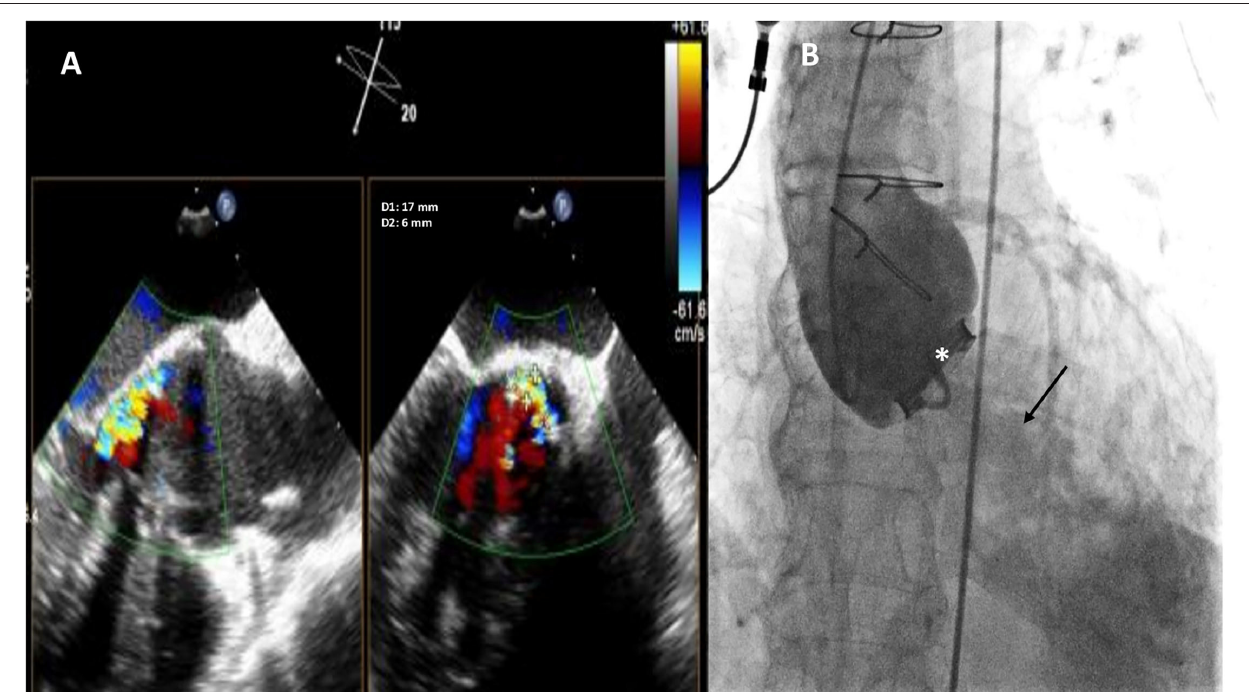
FIGURE 1 | Baseline two-dimensional (2D) X-plane imaging Transoeophageal Echocardiogram (TEE) color Doppler (A) and ascending aorta angiography (B) showing the presence of a huge crescent-shaped 17 × 6mm aortic PVL located at non coronary cusp (NCC) 9-12 o’clock, with moderate-to-severe regurgitation. Fluoro-angiographic image confirming the stable position of the mechanical tilting disc aortic prosthetic valve (white asterisk) with moderate regurgitation (black